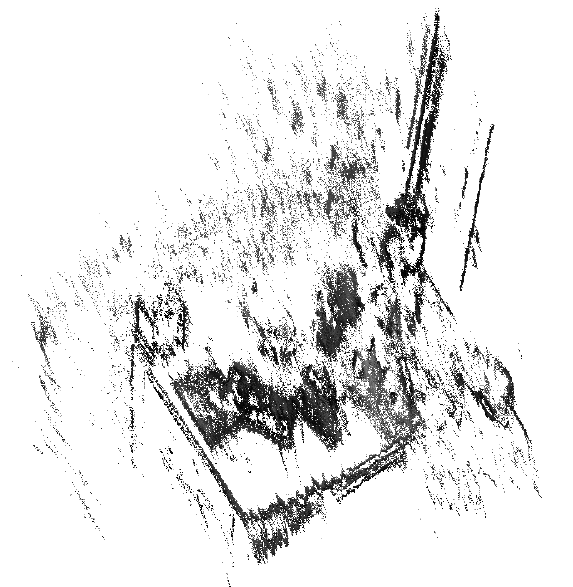
Figure 5. 3D point cloud of a sample scene recorded by a Raytrix R5 camera after applying the LSD-SLAM algorithm to the recorded sequence totally focused images without using the light-field based depth information.